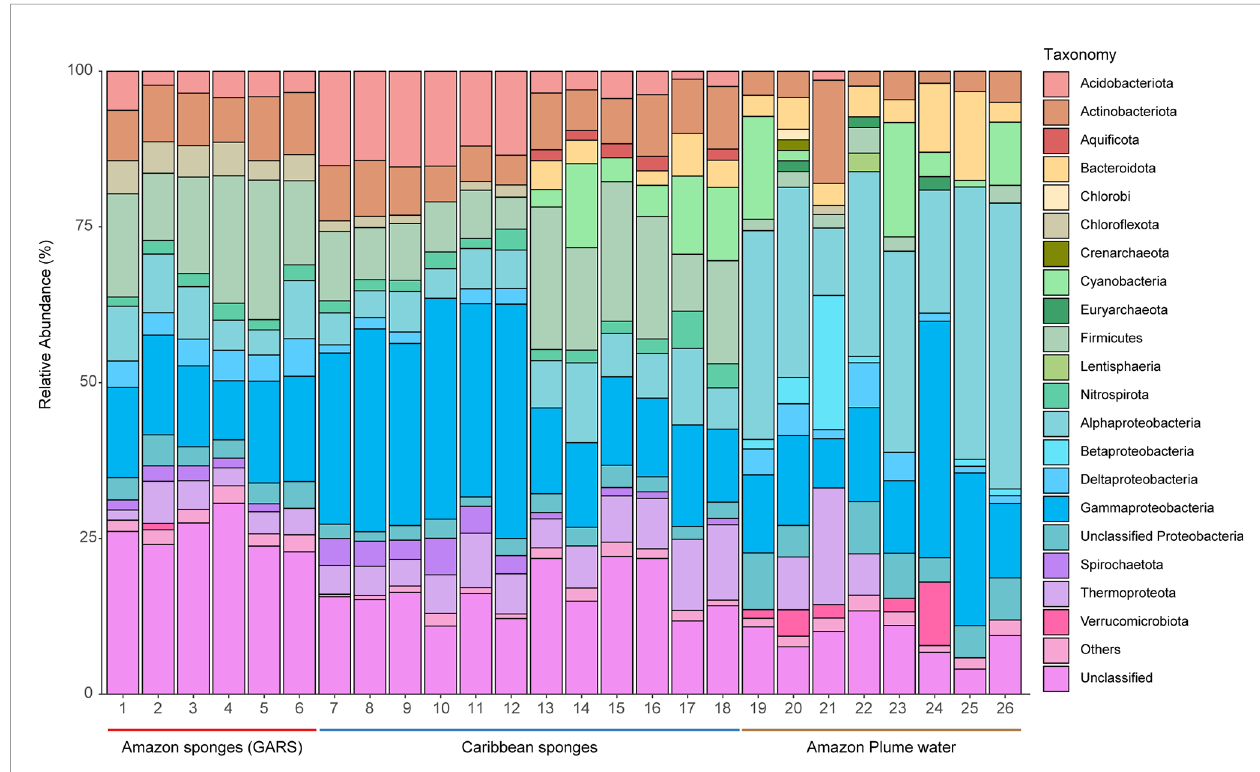
FIGURE 1 | Relative abundance of 16S ribosomal RNA (16S rRNA) sequences in different microbiomes from GARS sponges, Caribbean sponges, and Amazon plume water. Amazon sponges (GARS) are highlighted with a red bar below: 1, Agelas dispar ; 2, Agelas clathrodes 1; 3 Agelas clathrodes 2; 4, Geodia cf. corticostylifera ; 5, Geodia neptuni ; 6, Geodia sp. Caribbean sponges are highlighted with a blue bar below. Carribean Geodia sp. samples: 7, SRS9041575; 8, SRS9041573; 9, SRS9041427; 10, SRS9041416; 11, SRS9041405; 12, SRS9041395. Carribean Agelas sventres samples: 13, SRR7068181; 14,